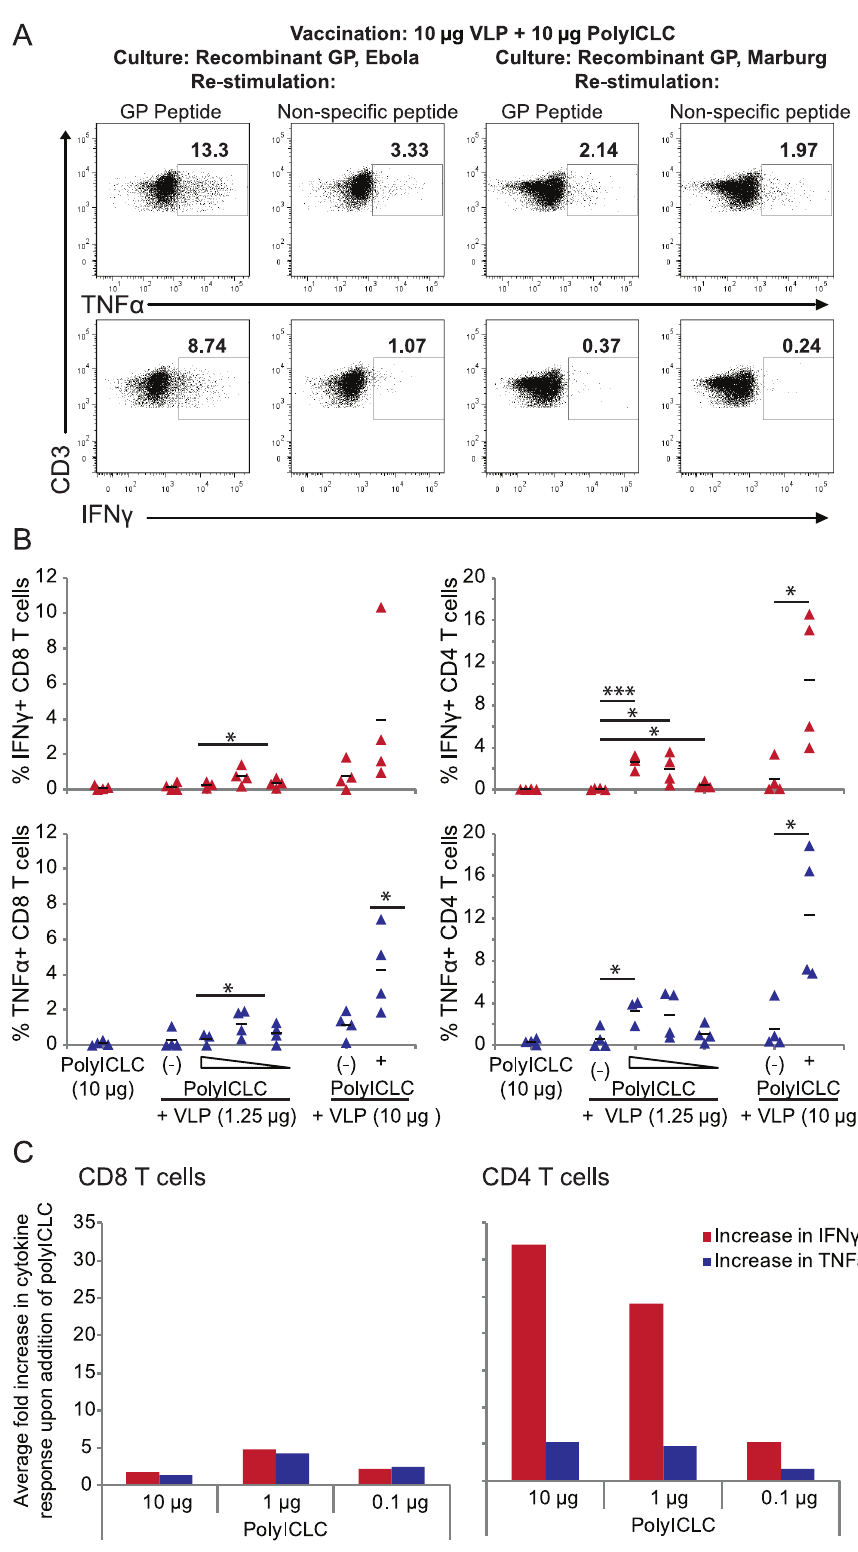
Figure 4. PolyICLC enhances antigen-specific T cell responses during VLP vaccination at suboptimal doses of antigen . C57BL/6 mice were vaccinated with polyICLC alone as a negative control, 10 m g of VLP, 10 m g of VLP with 10 m g of polyICLC, 1.25 m g of VLP, or 1.25 m g of VLP with 10, 1 or 0.1 m g of polyICLC. Three weeks later animals received a vaccine boost; four weeks later, animals were euthanized and splenocytes were collected. (A) Representative flow data are shown with CD3 on the y-axis and IFN c or TNF a on the x-axis, after gating on lymphocytes, viable CD3 + cells, and CD4 + T cells. Data are from one representative animal vaccinated with the 10 m g of VLP + 10 m g of polyICLC, then cultured with either Ebola